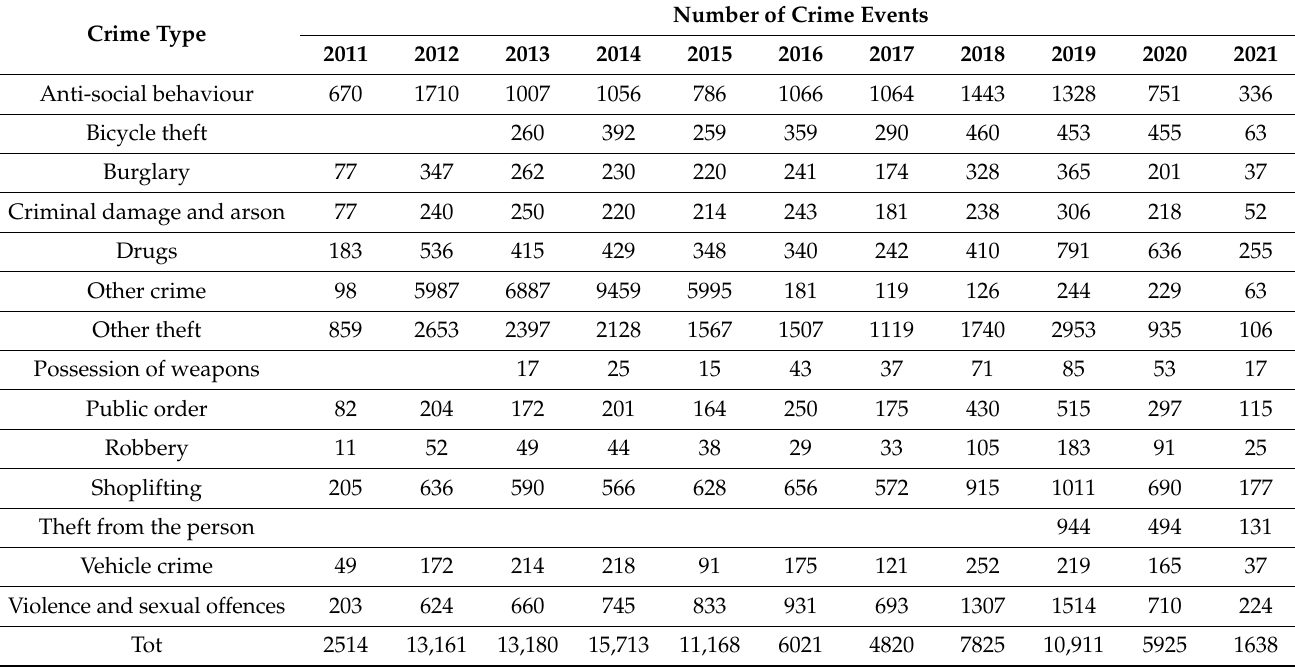
Table 1. Number of crime events that occurred in the City of London from September 2011 to July 2021.